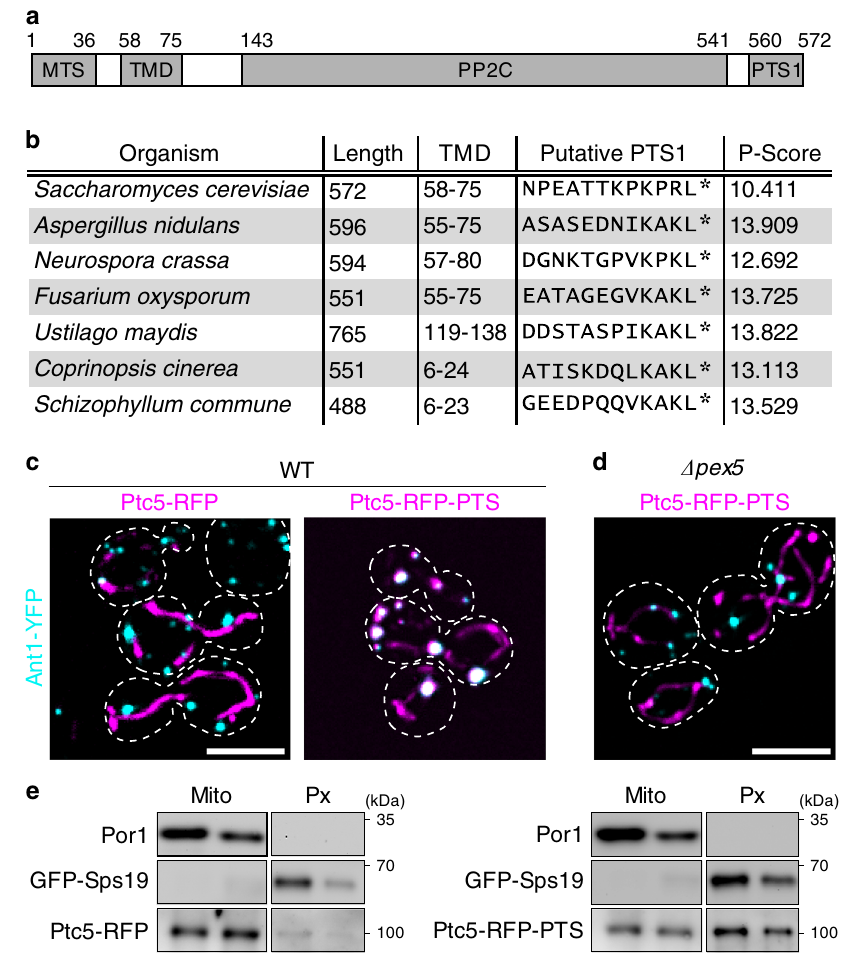
Fig. 1 Ptc5 is localized in mitochondria and in peroxisomes. a Domain structure of Ptc5 from S. cerevisiae . MTS, TMD, and PTS1 refer to the mitochondrial targeting signal, the transmembrane domain and the peroxisomal targeting signal, respectively. PP2C speci fi es the position of the phosphatase domain. b Phylogenetic conservation of the depicted domain architecture among fungi. The P -score is a measure for peroxisomal targeting probability based on the C-terminal dodecamer 64 . c Fluorescence microscopic pictures of wild-type (WT) yeast cells expressing either Ptc5-RFP or Ptc5-RFP-PTS (magenta) together with the peroxisomal membrane protein Ant1-YFP (cyan). White color indicates colocalization. Scale bar represents 5 µ m. d